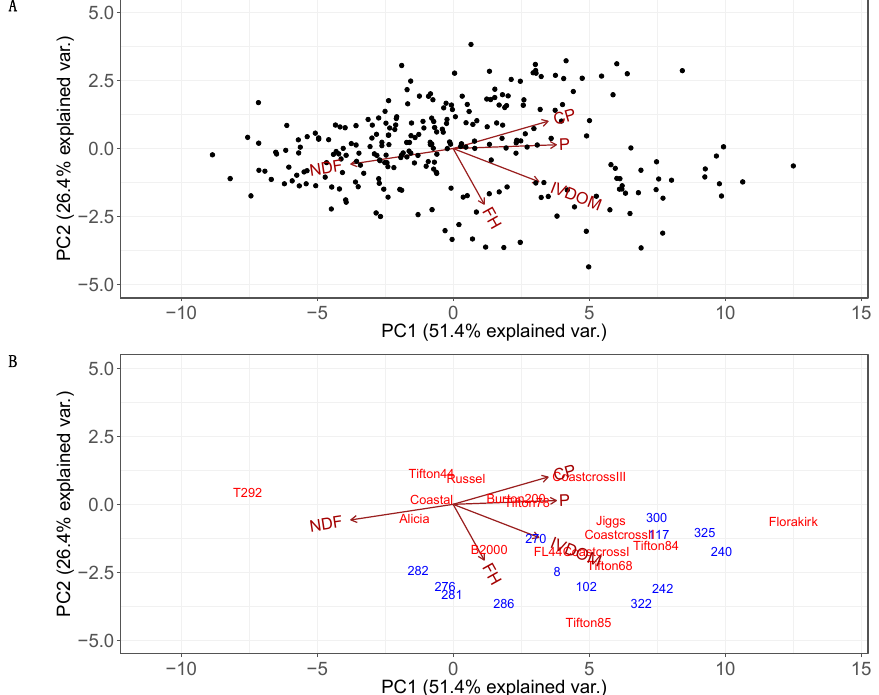
Figure 3. Principal Components Analysis (PCA) estimated for the USDA-NPGS bermudagrass germplasm collection and commercial cultivars. Black loadings represent predicted values for five traits estimated for the whole collection ( A ), and loadings colored only for 17 cultivars (red) and 15 selected accessions (blue) ( B ). The plants were grown at Citra, FL, and five traits were determined using wet chemistry: crude protein concentration—CP, phosphorus concentration—P, in vitro digestible organic matter—IVDOM, neutral detergent fiber—NDF, and forage harvested—FH. The selected accessions were identified by field ID instead of plant introduction numbers to improve visibility in the graph.